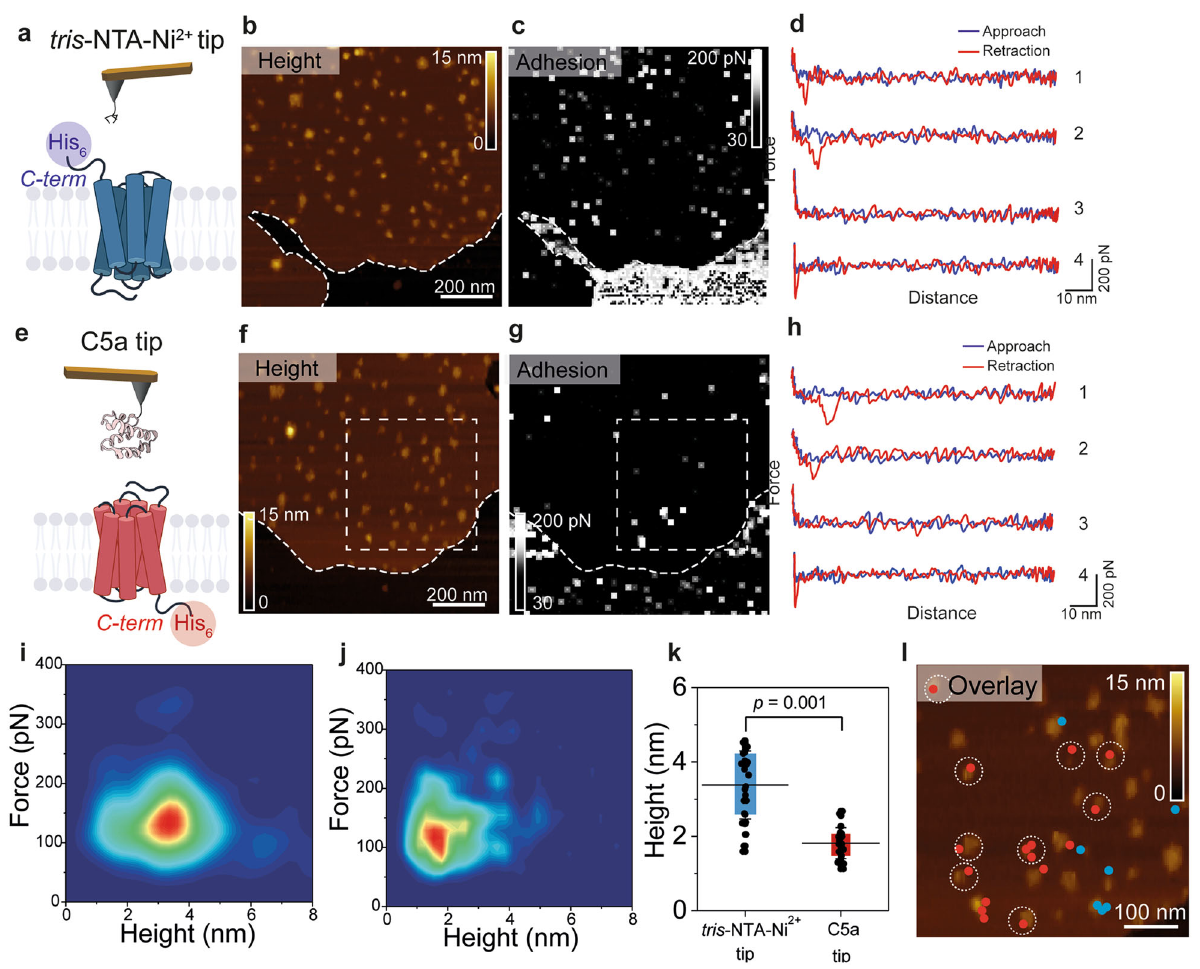
Fig. 2 Multiplex probing of C5aR intra- and extracellular binding sites as a method discriminate C5aR orientation within lipid membrane. Two different AFM tip chemistries were used to target either the His 6 -tag C-terminal end of C5aR using tris -NTA – Ni 2 + functionalized AFM tips ( a – d ) or the N-terminal end of C5aR using the endogenous C5a ligand ( e – h ). AFM height and adhesion images were recorded over the same lipid patch with a tris -NTA – Ni 2 + tip ( b ) and ( c ) and a C5a ligand tip ( f ) and ( h ). d , h Representative FD curves showing either speci fi c adhesion events (curves 1, 2) or no/unspeci fi c interactions (curves 3, 4) were extracted from the adhesion maps in ( c ) and ( g ). 2D histograms of force vs. height for tris -NTA – Ni 2 + modi fi ed tips ( i ) and C5a tips ( j ). k Height distribution of the receptors interacting with the tris -NTA – Ni 2 + or the C5a tip. Two populations can be clearly distinguished, one below 1.75 nm in height, where C5a tips mostly interact with the extracellular side of C5aR, and another one above 3.5 nm in height, where tris -NTA – Ni 2 + functionalized tips interact with the intracellular side of C5aR. l Height map overlay of the region marked by a white square in ( f ) and corresponding speci fi c adhesion events extracted from the same areas in the maps in ( c ) and ( g ). Adhesion events between the C5a ligand and the N-terminal side of C5aR are shown as red dots, while the events rising from the tris -NTA – Ni 2 + AFM tip interaction with the His 6 -tagged C-terminal side of C5aR are displayed as blue dots. White dotted circles mark receptors with a height less than 1.75 nm, where the C5a ligand and the N-terminal side of C5aR interact. The overlay image shows how the orientation of single C5aR particles can be identi fi ed using our multiplex probing method. Data are representative of at least three independent experiments. Data in ( k ) are displayed as mean ± S.D. and the ANOVA one-way Tukey test was used to report the statistical signi fi